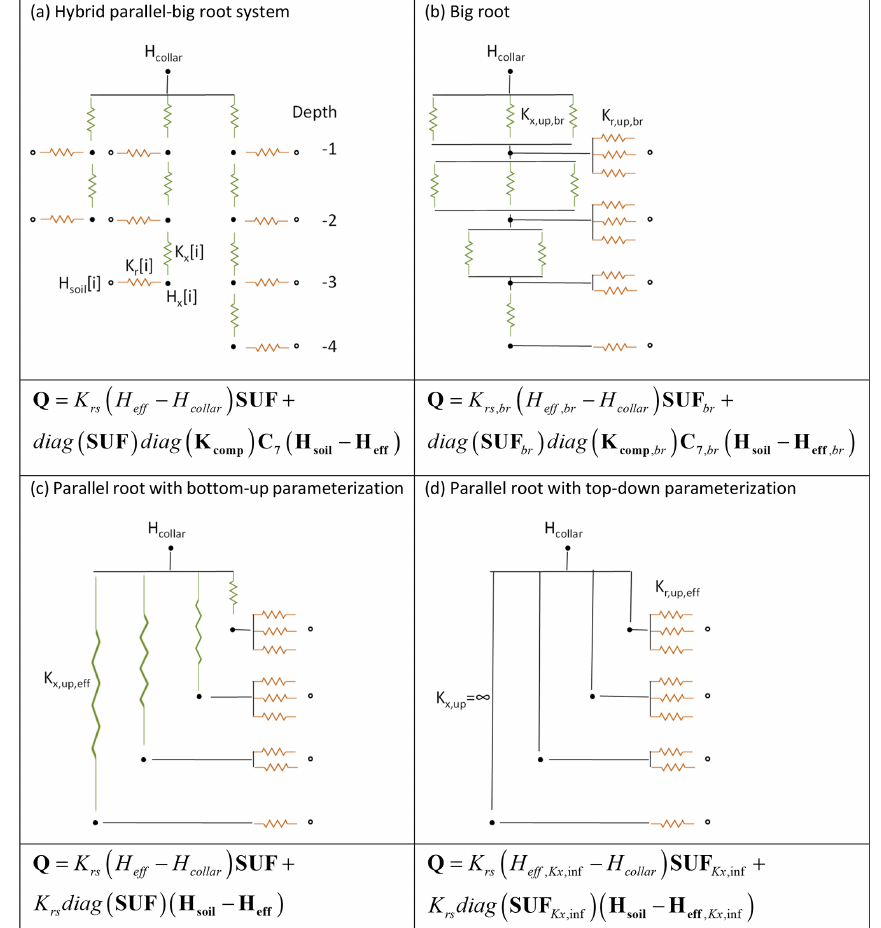
Figure 3. Resistance nets representing the hybrid parallel–big root system consisting of three primary root branches of different lengths (a) . There are also approximations by the big root model (b) , the parallel root model using a bottom-up parameterization (c) , and the parallel root model with a top-down parameterization (d) . The closed circles represent root nodes and the open circles soil nodes; the brown and green resistors represent radial and axial root segment conductances, respectively. The approximate models describe upscaled root water uptake from four depths. The SUF br , K rs,br , K comp,br , and C 7,br of the big root model are calculated from the segment axial and radial conductances that are arranged following the big root topology in parallel within a soil layer from which upscaled big root segment conductances K r,up,br and K x,up,br are calculated (top-down parameterization). The SUF and K rs of the parallel root model with bottom-up parameterization (c) are matched to those of the upscaled hybrid model by adapting the axial conductance K x,up,eff of the segment that connects the xylem node at a certain depth to the collar node. The SUF of the parallel root model with top-down parameterization, assuming infinite K x,up (d) , is derived from the distribution of radial root segment conductances with depth, which are scaled to K r,up,eff so that K rs matches that of the hybrid root system. The equations below the resistance nets represent the equations that calculate the upscaled water uptake Q in a horizontal